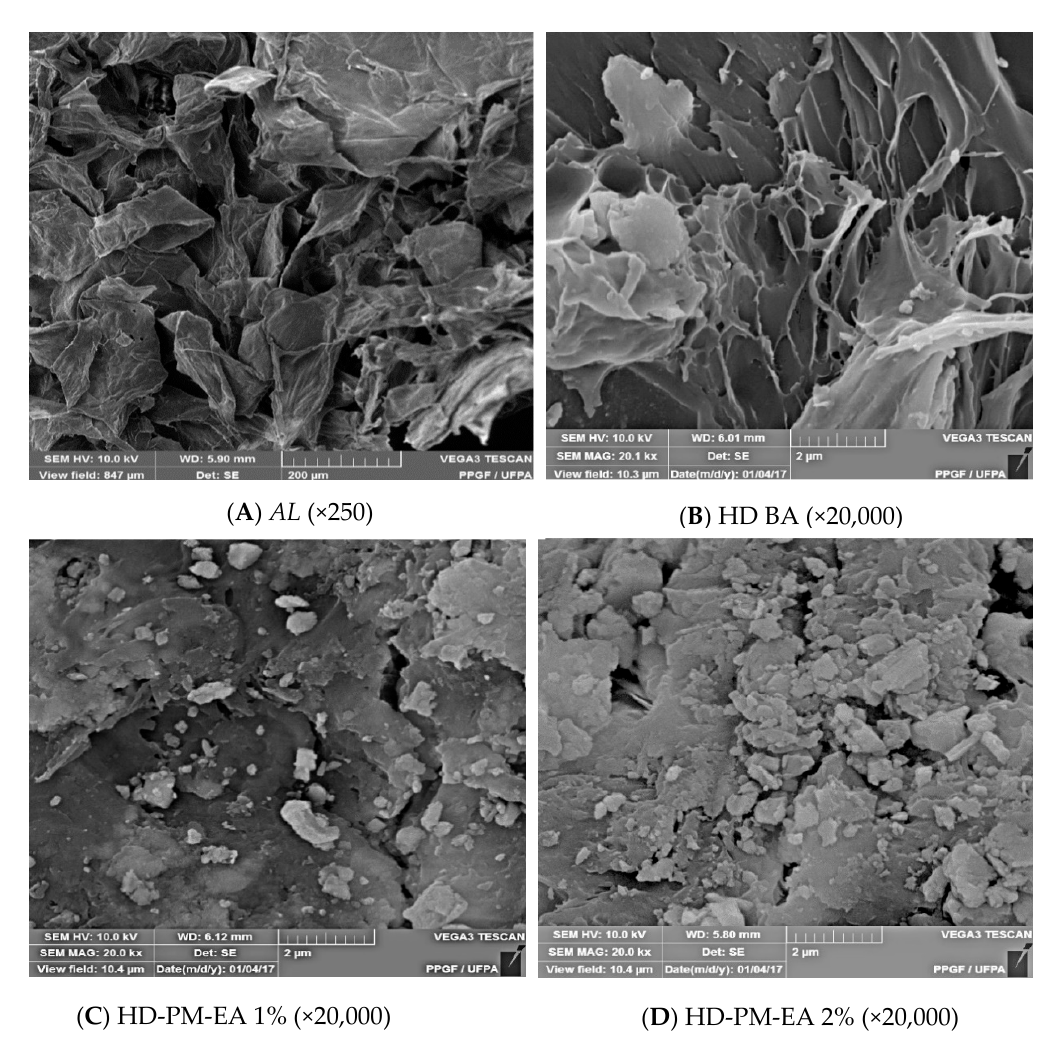
Figure 5. Photomicrographs of Aloe barbadensis (AL) ( A ), basic hydrogel (HD BA) ( B ), HD-PM-EA 1% ( C ), and 2% ( D ).